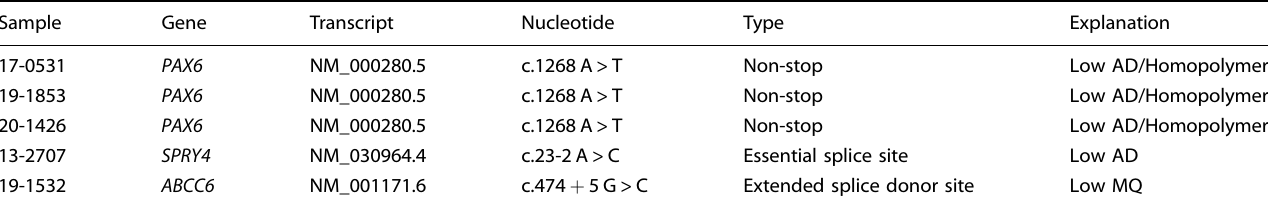
Table 1. Discordant variants only detected by the Sophia pipeline in the CES